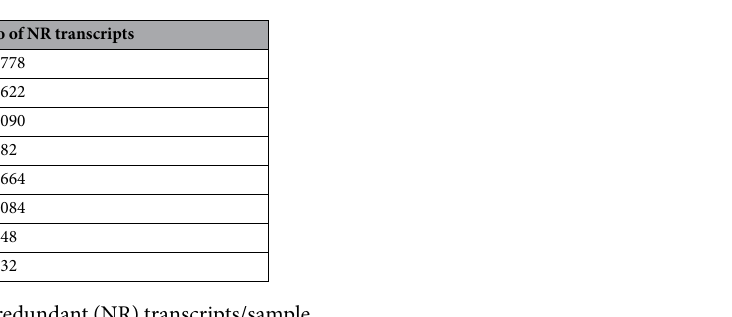
Table 2. Number of non redundant (NR)